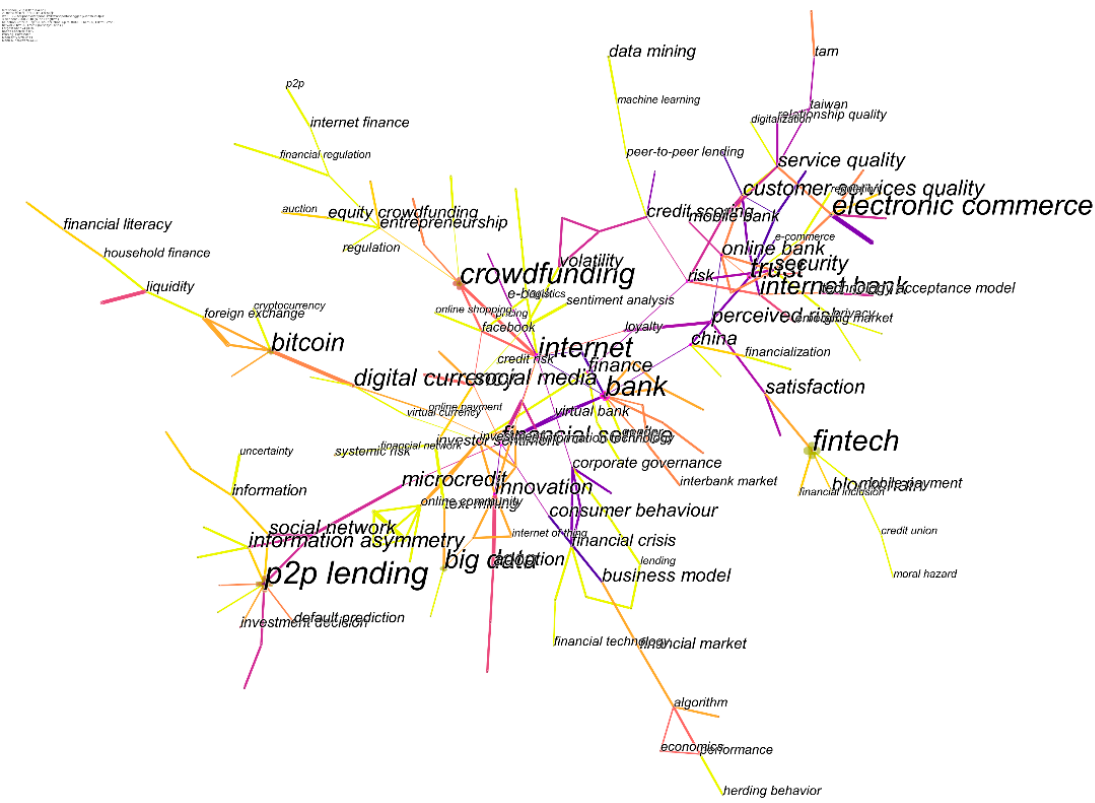
Figure 1. Co-word network of keywords. Table 2. Number and color of each pattern directly connected to them.